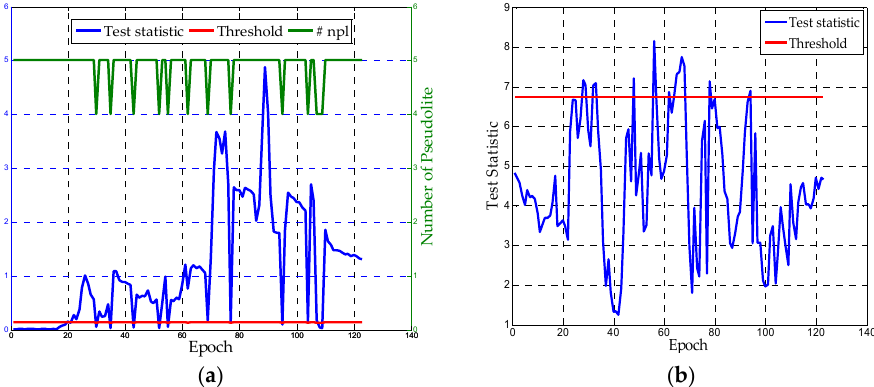
Figure 13. ( a ) The Test Statistics Based on Carrier Phase Observations, ( b ) The Test Statistics Based on Pseudorange Observations.